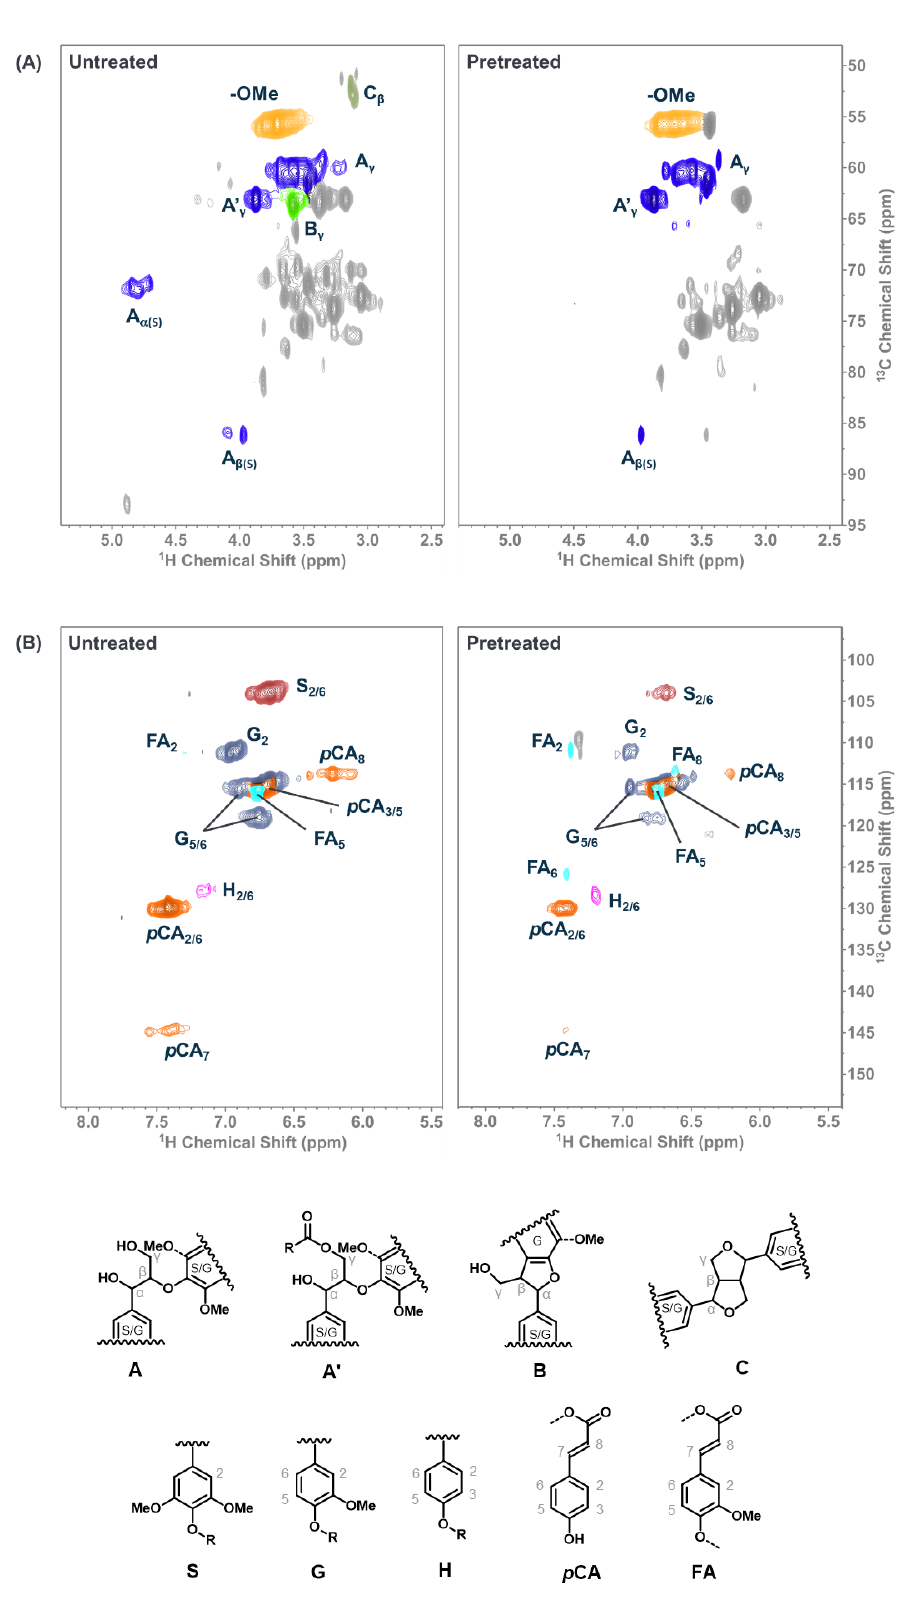
Figure 6. ( A ) Side-chain and ( B ) aromatic regions in the 2D HSQC NMR spectra of untreated ( left ) and pretreated ( right )